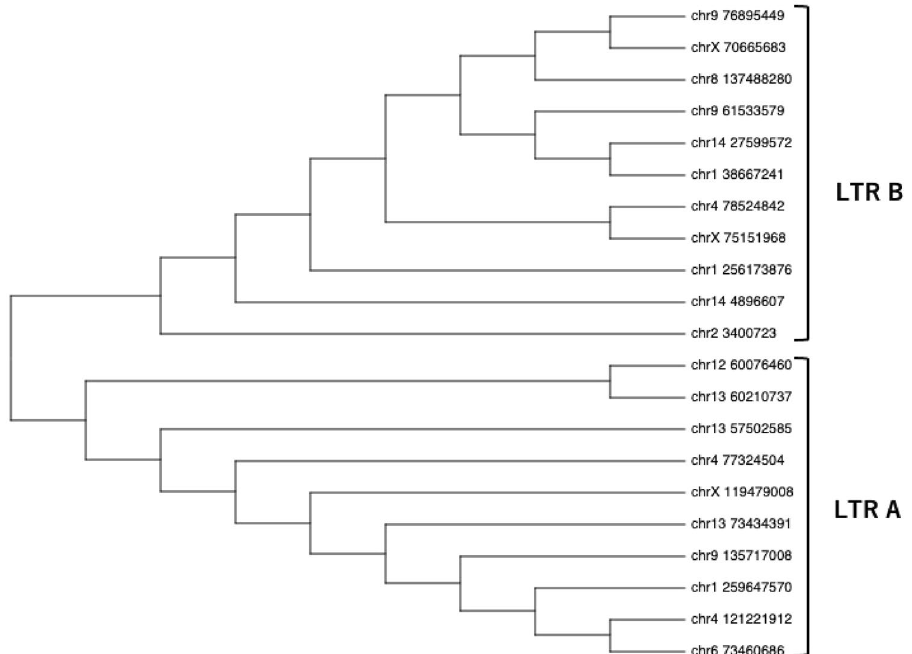
Figure 3. Phylogenetic tree of non-reference long terminal repeats (LTRs). The tree with the highest log likelihood (− 2693.75) is shown. A discrete gamma distribution was used to model the differences in evolutionary rate among sites (five categories; + G, parameter = 0.9509). This analysis involved 21 LTR sequences. There were 796 positions in the final dataset and two main clusters (LTR-A and LTR-B) were obtained.